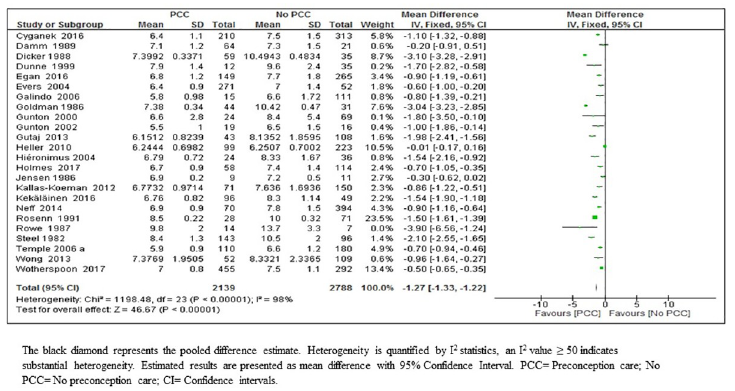
Fig 4. First trimester means values of glycosylated hemoglobin (HbA1c) from 24 studies of women with pre- existing diabetes mellitus who did or did not receive preconception care.